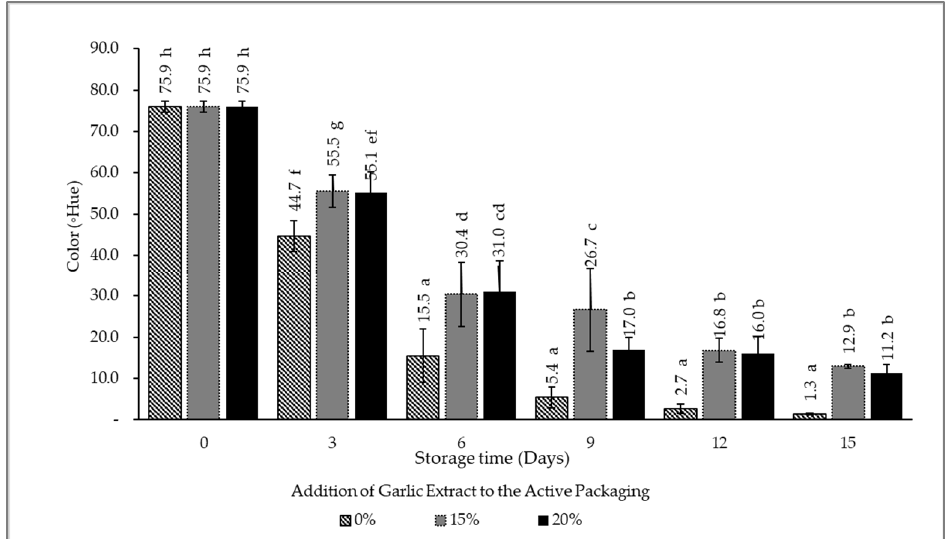
Figure 2. Graph for the Hue value of the indicator label during storage. The mean value followed by various letters indicates a significant difference ( p -value < 0.05).